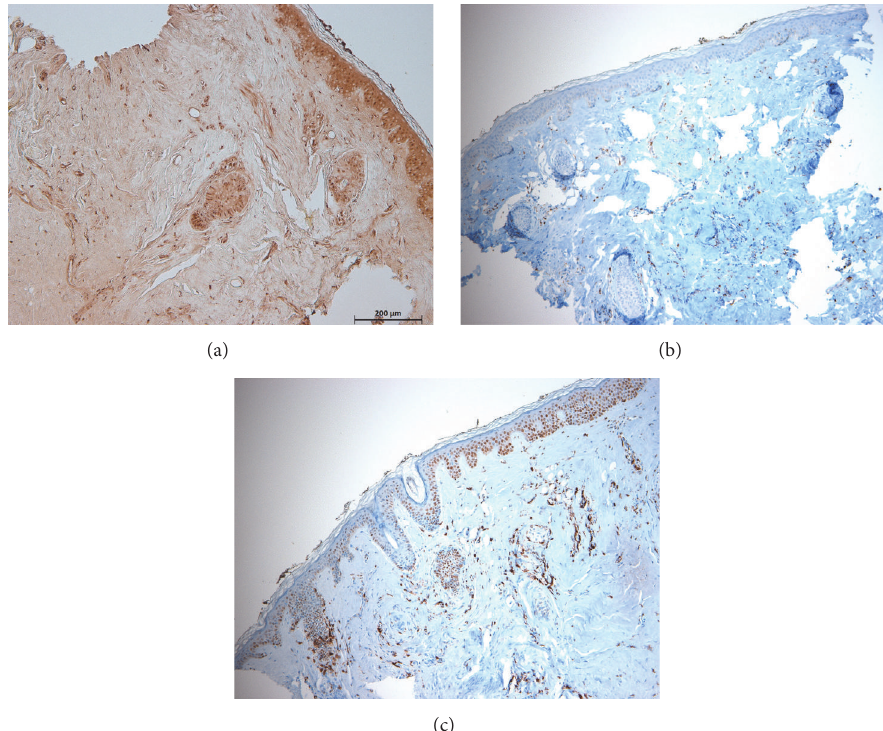
Figure 3: (a) Most MMP-9-expressing spindle shape cells in the dermis showed immunopositivity for (b) CD-68 or (c) CD45 (magnification: × 100).